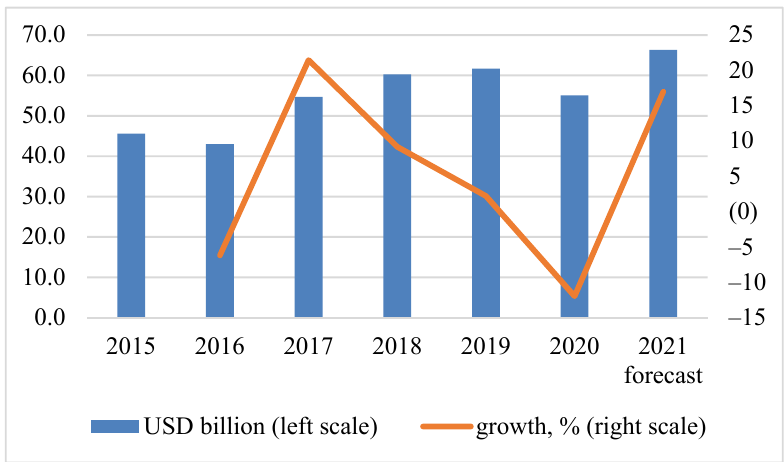
Figure 1. Dynamics of mutual trade of the EAEU, million US dollars. Source: Own calculations based on the Eurasian Commission (2021).